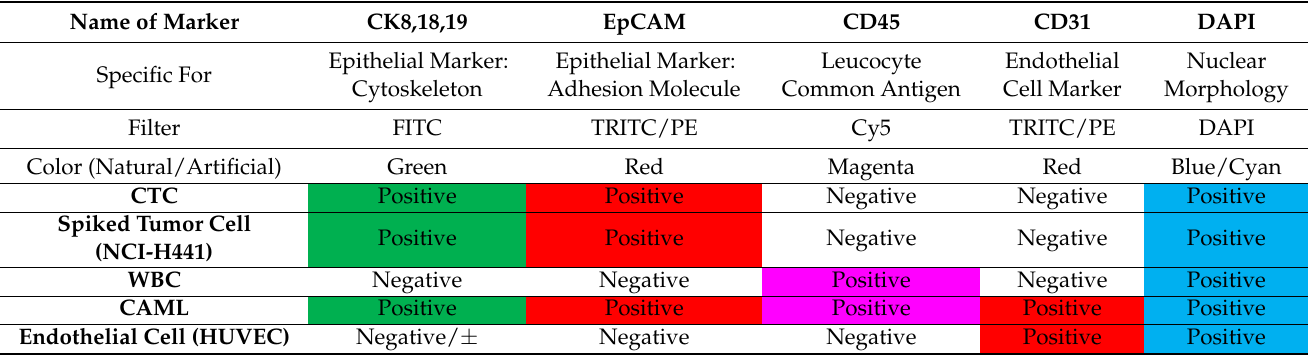
Table 6. Specific sets of markers were used to detect CAMLs, CTCs, WBCs, spiked tumor cells, and endothelial cells by